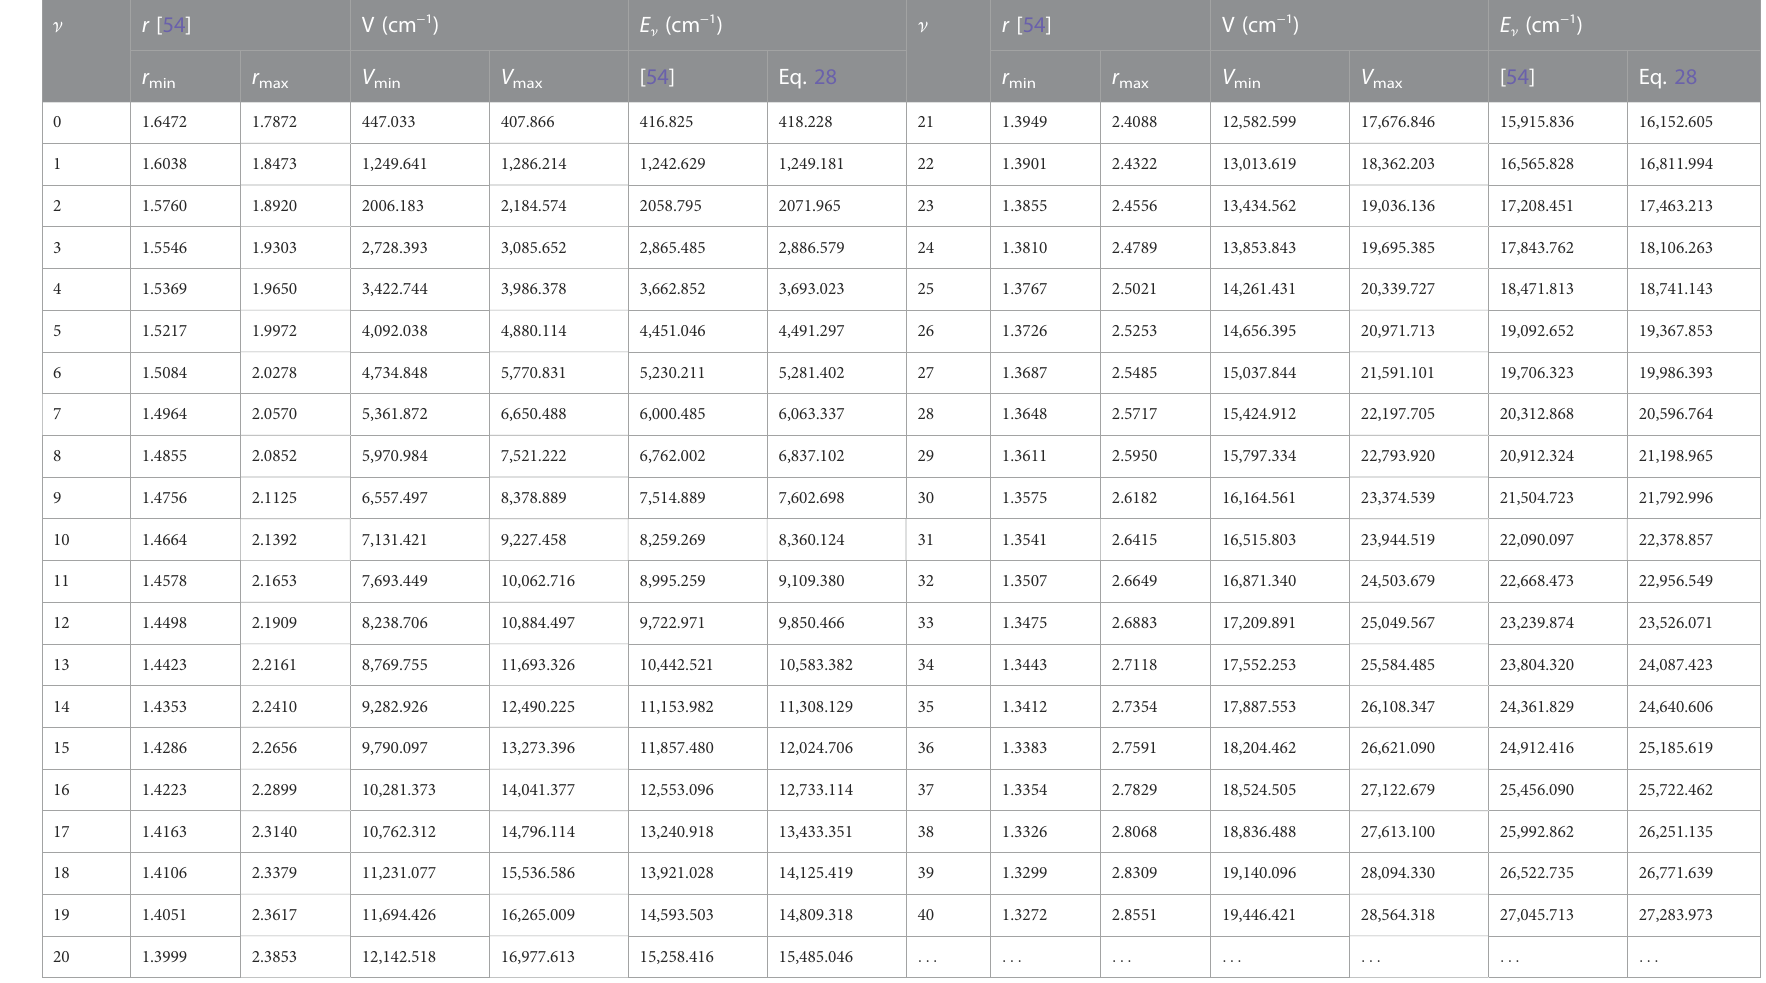
TABLE 2 Potential energies (cm) and bound state pure vibrational state energies (cm − 1 ) as a function of internuclear separation (Å) for the BCl (X 1 Σ + )